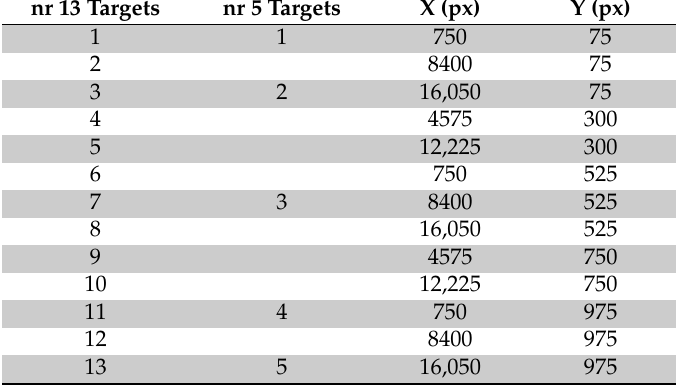
Table 2. Targets’ coordinates in pixels (maximum values of horizontal and vertical dimensions correspond to the values of 1680 px and 1050 px,